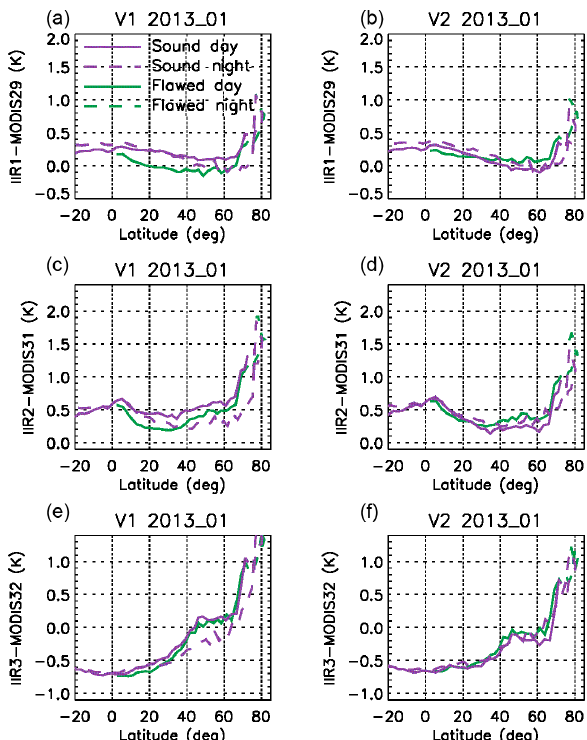
Figure 14. Same as Fig. 13 but for January